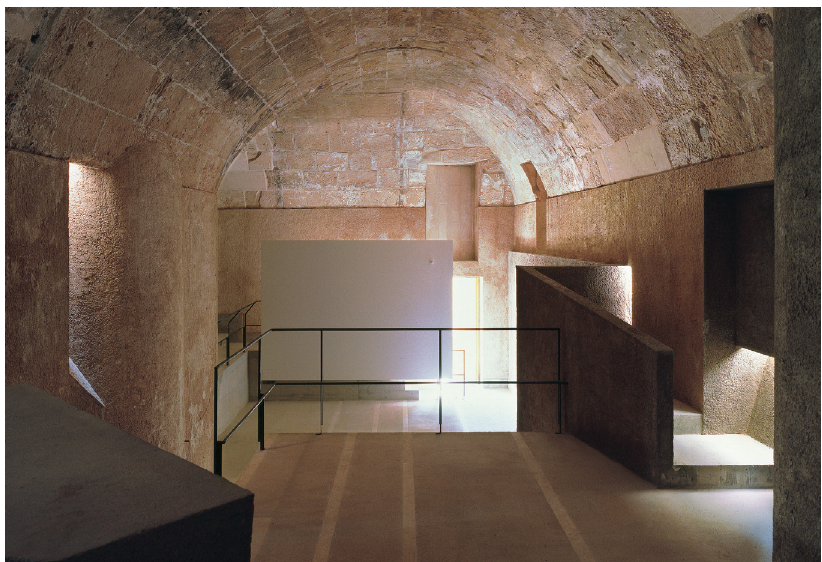
Figure 3. Flores Prats, Mills Museum. Palma de Majorca, 1999–2002. Interior. Photograph by Duccio